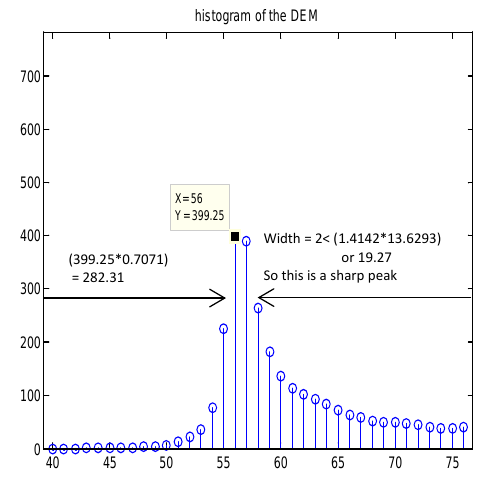
Figure 5. Peak width calculation for selecting sharp peaks